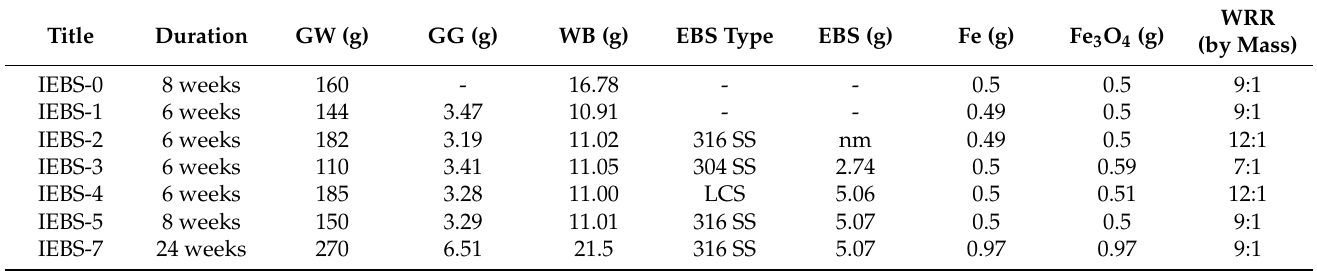
Table 1. Initial components and reaction conditions for IEBS experiments in the presence of Grimsel granodiorite. Abbreviations: LCS, low carbon steel; SS, stainless steel; GW, groundwater; GG, Grimsel granodiorite; WB, Wyoming bentonite; EBS, engineered barrier material. Note that IEBS-2, -5, and -7 represent replicate experiments with increasing experimental durations. All experiments were conducted at 250 ◦ C.